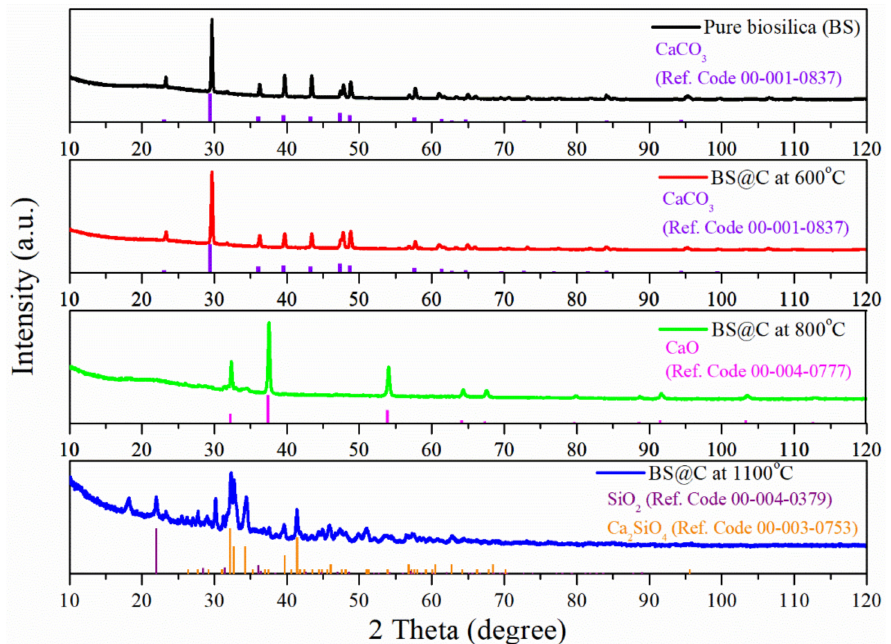
Figure 3. Powder X-ray di ff raction patterns of the dried diatom biomass and diatom biomass pyrolysed at 600 ◦ C, 800 ◦ C and 1100 ◦